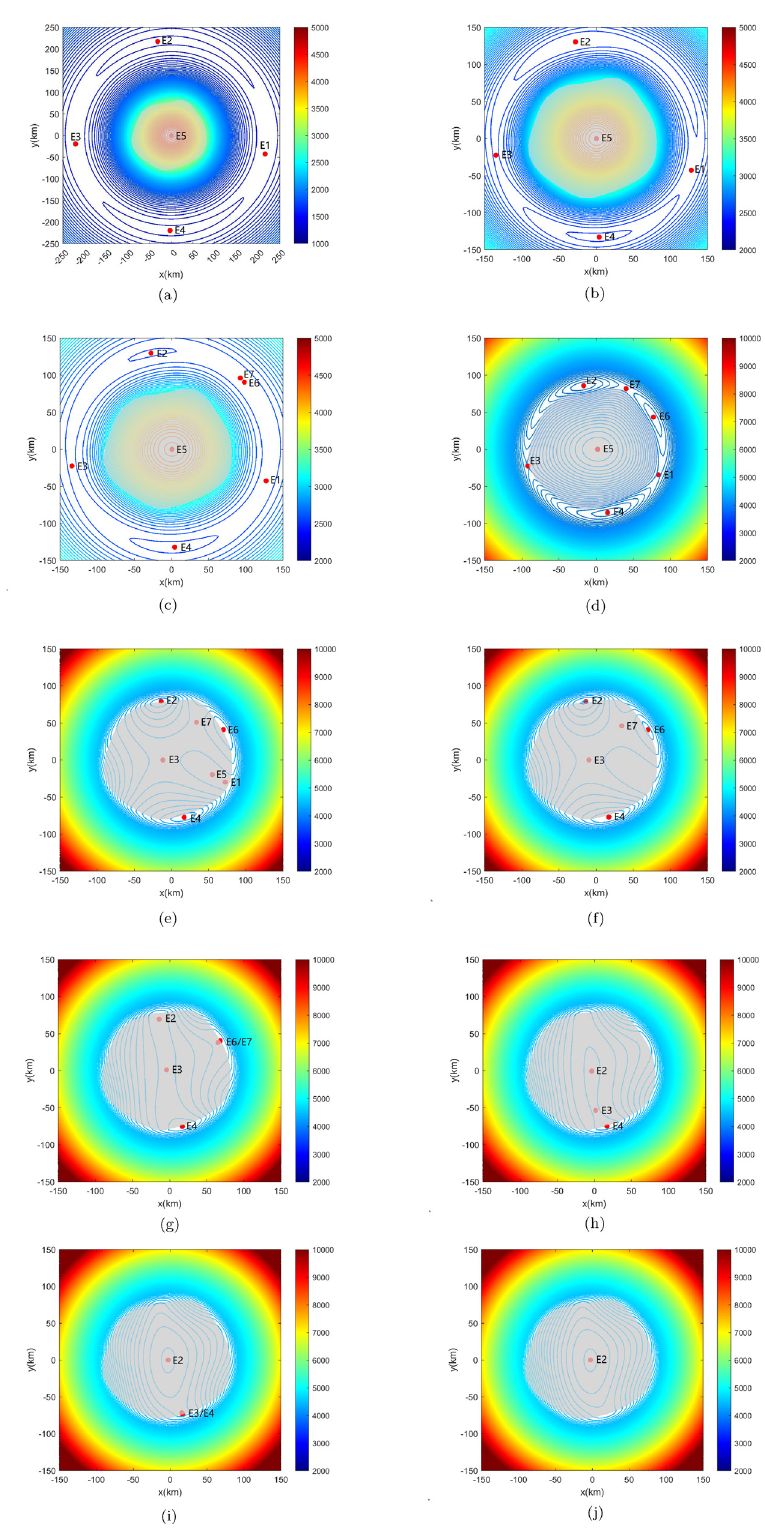
Figure 5: Some typical locations of equilibrium points of asteroid Minerva when increasing the spin speed. ( a )